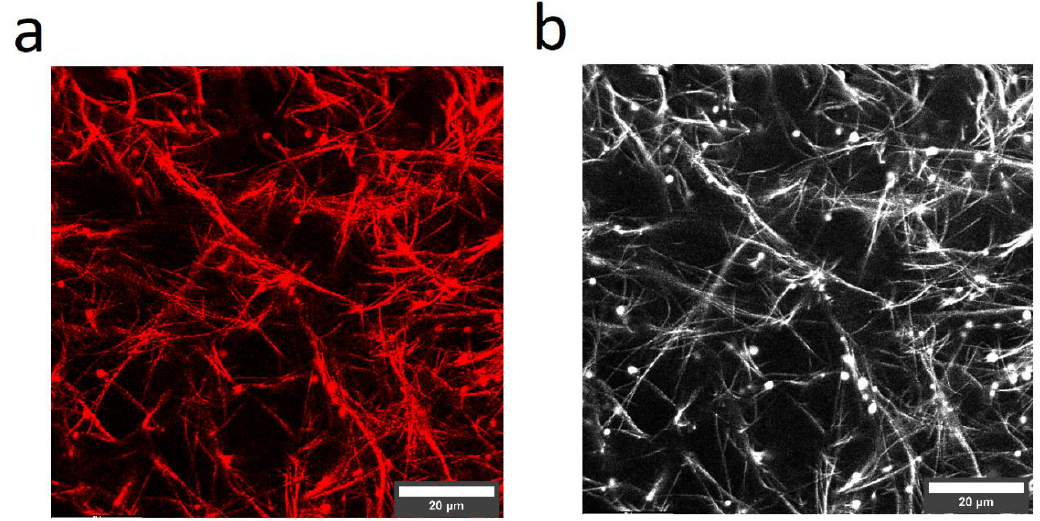
Figure 5. Fluorescence images of a 33.3 w% elastin – collagen gel. ( a ) collagen type I antibody and ( b ) Col-F. The dots in each image are most likely clustered elastin – collagen monomers. The right image (Figure 5b) shows all the network features (collagen + elastin).